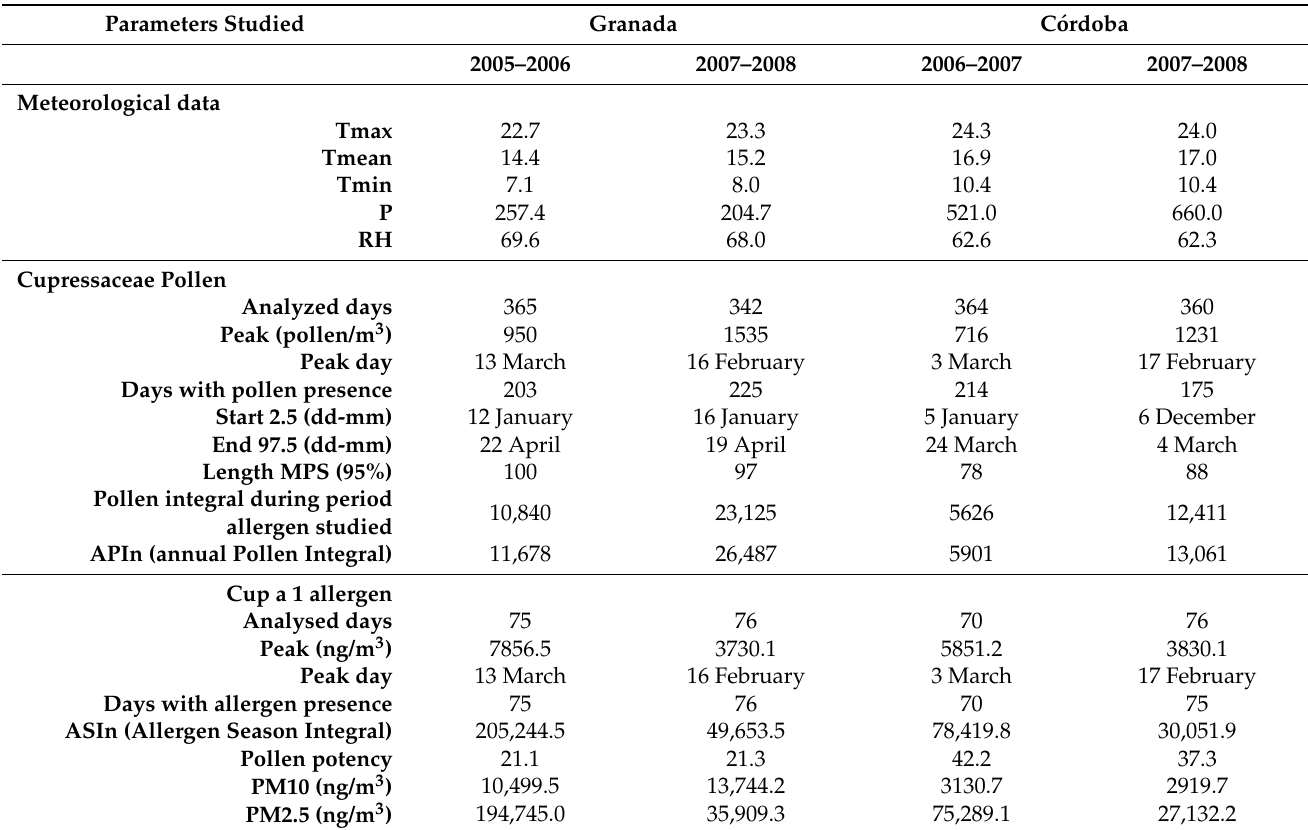
Table 1. Meteorological data, Cupressaceae pollen, and Cup a 1 allergens’ parameter in Granada and C ó rdoba. APIn is considered from 1 September to 31 August, while SPIn is 15 January to 31 March. Parameters